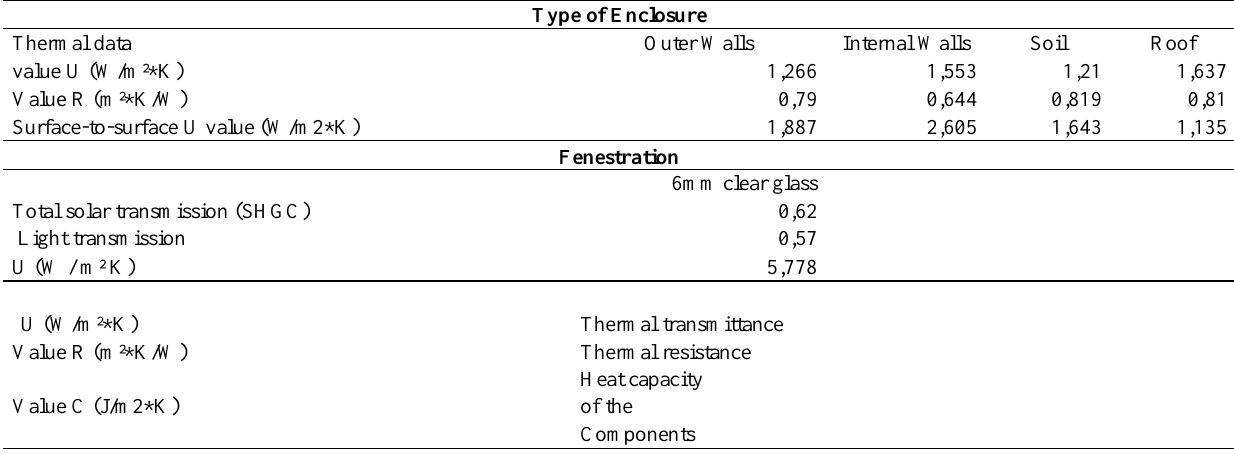
Figure 3. Geographic location and orientation of the case study architecture Table 2 Thermal characterization of the enclosures of the houses to be